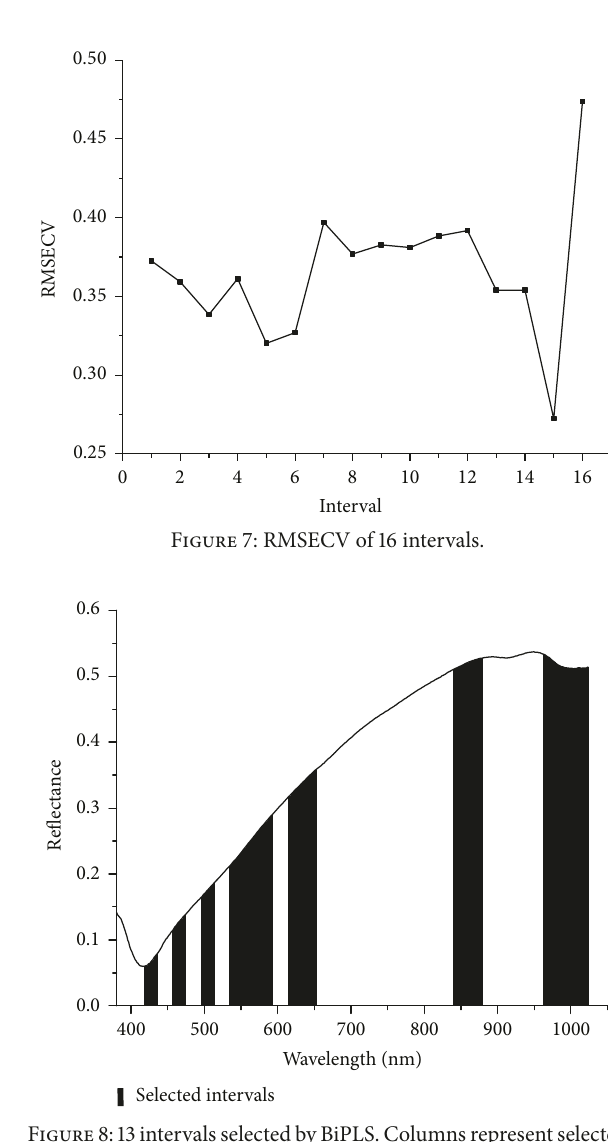
Figure 6: Minimum RMSECV of different number of intervals.